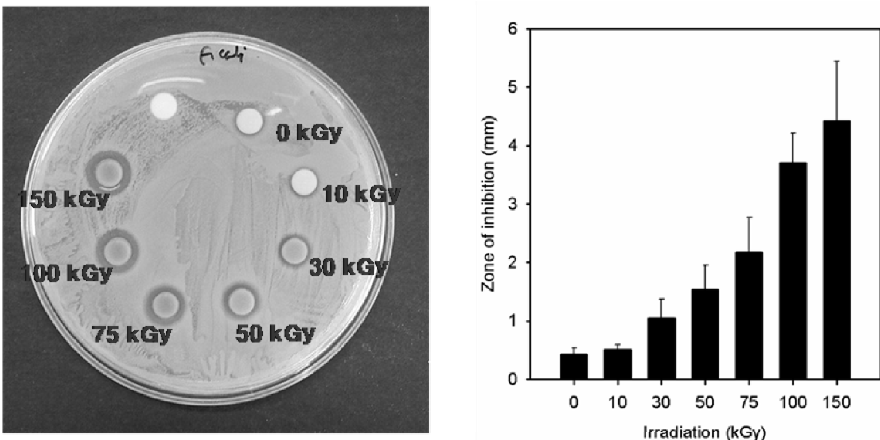
Figure 8. Zone of inhibition of silver nanoparticles against Escherichia coli ; PAAc 1 wt%, Hexane 3 wt%, AgNO 0.005 M. 3